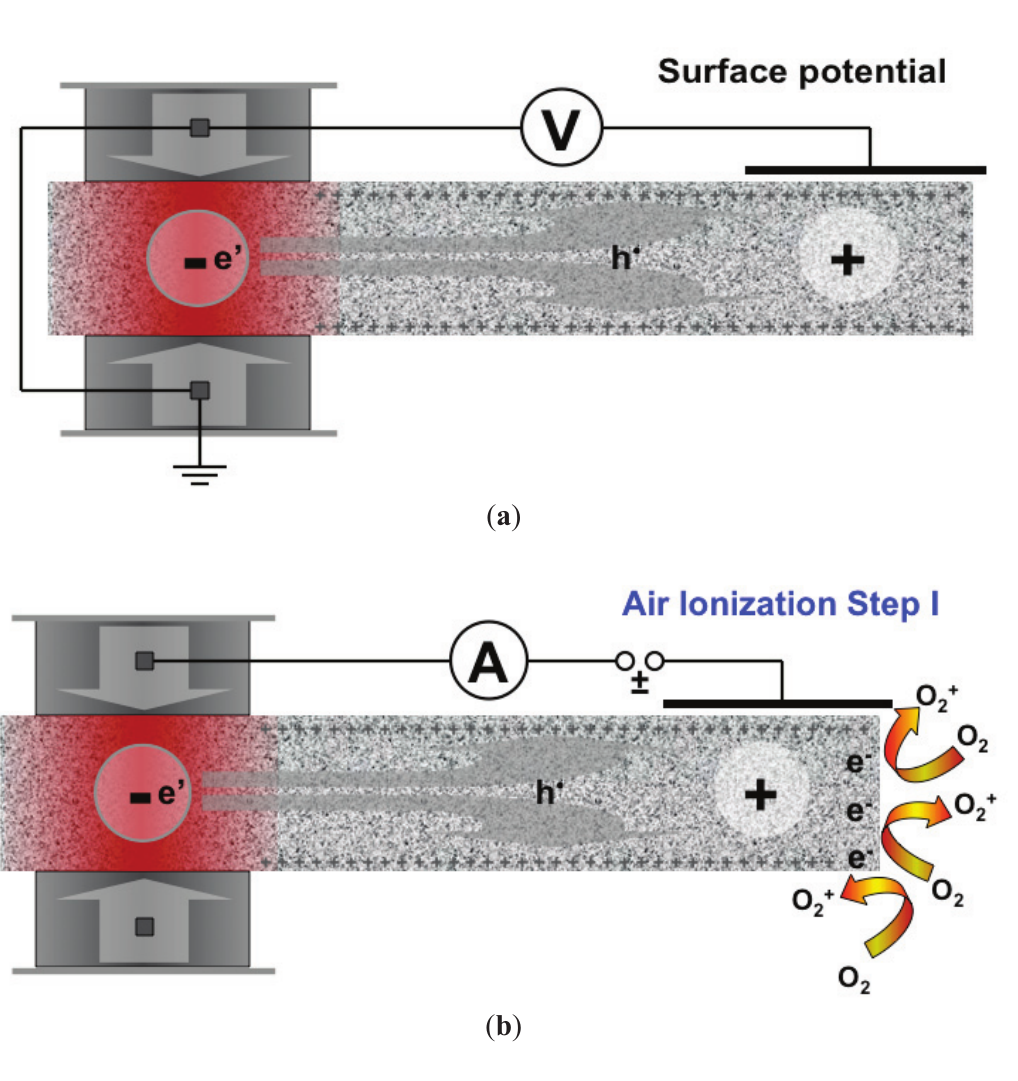
Figure 4. Laboratory set-up to measure surface potential ( a ) and air ionization ( b ) during stressing a block of rock